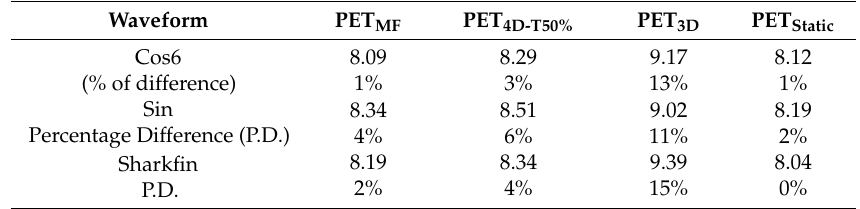
Table 2. Target volumes delineated by different positron emission tomography (PET) images taken from the CIRS dynamic thorax phantom under various waveforms. The percentage of difference was calculated from volume contour and gold standard volume (8 cm 3 ). MF-Motion Freeze.